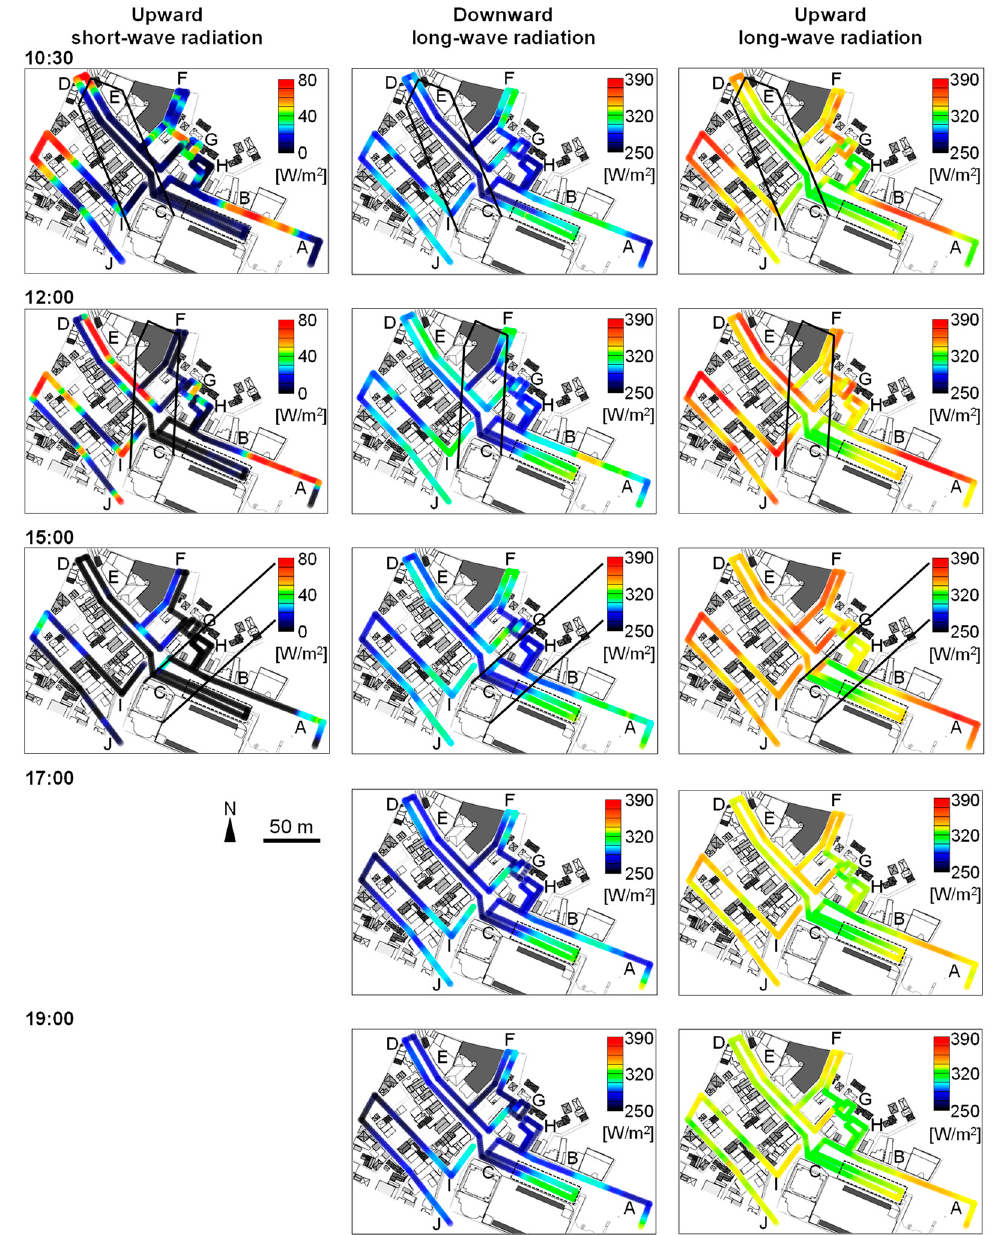
Figure 9. Results of mobile observations: the black line indicates the shadow diagram of the high-rise building whilst the broken line represents a large roof constructed in front of the commercial building. Names of the sections are depicted by A–J. Representative air temperature (T a ′ ) is depicted for each time period.